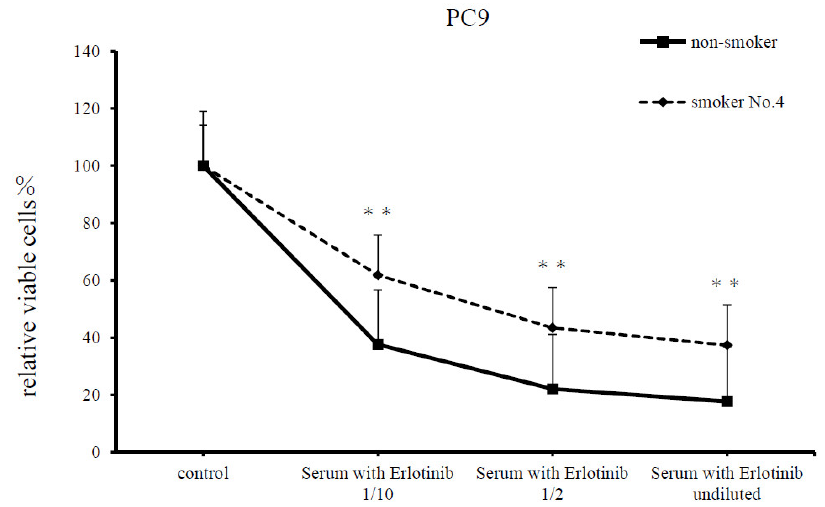
Figure 5. Treatment of PC9 cells with serum from smoker-induced erlotinib resistance following treatment with serum from an erlotinib user. Analysis of PC9 cells treated with serum from a non-smoker or smoker No. 4 for 24 h, followed by serum from erlotinib users (1:10 or 1:2 dilutions, or undiluted) for 120 h. Serum from smokers significantly reduced erlotinib sensitivity (** p < 0.001). Cell survival was assessed using a cell counting kit (CCK)-F. Results are means ± SEM of four independent